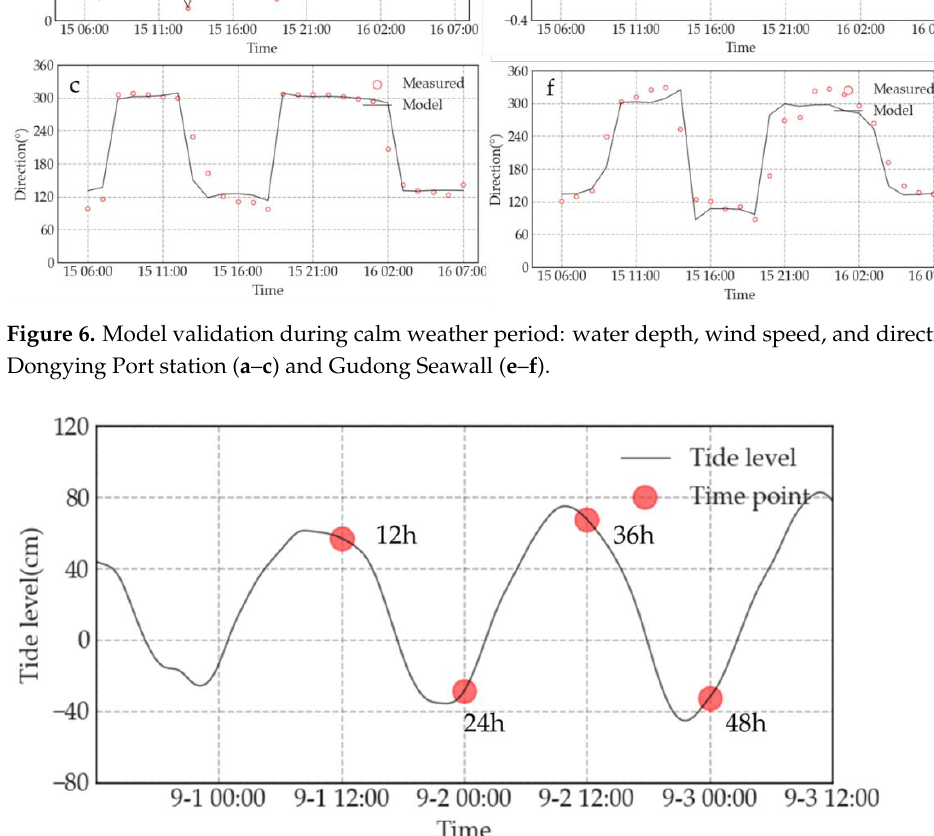
Figure 6. Model validation during calm weather period: water depth, wind speed, and direction at Dongying Port station ( a – c ) and Gudong Seawall ( e – f